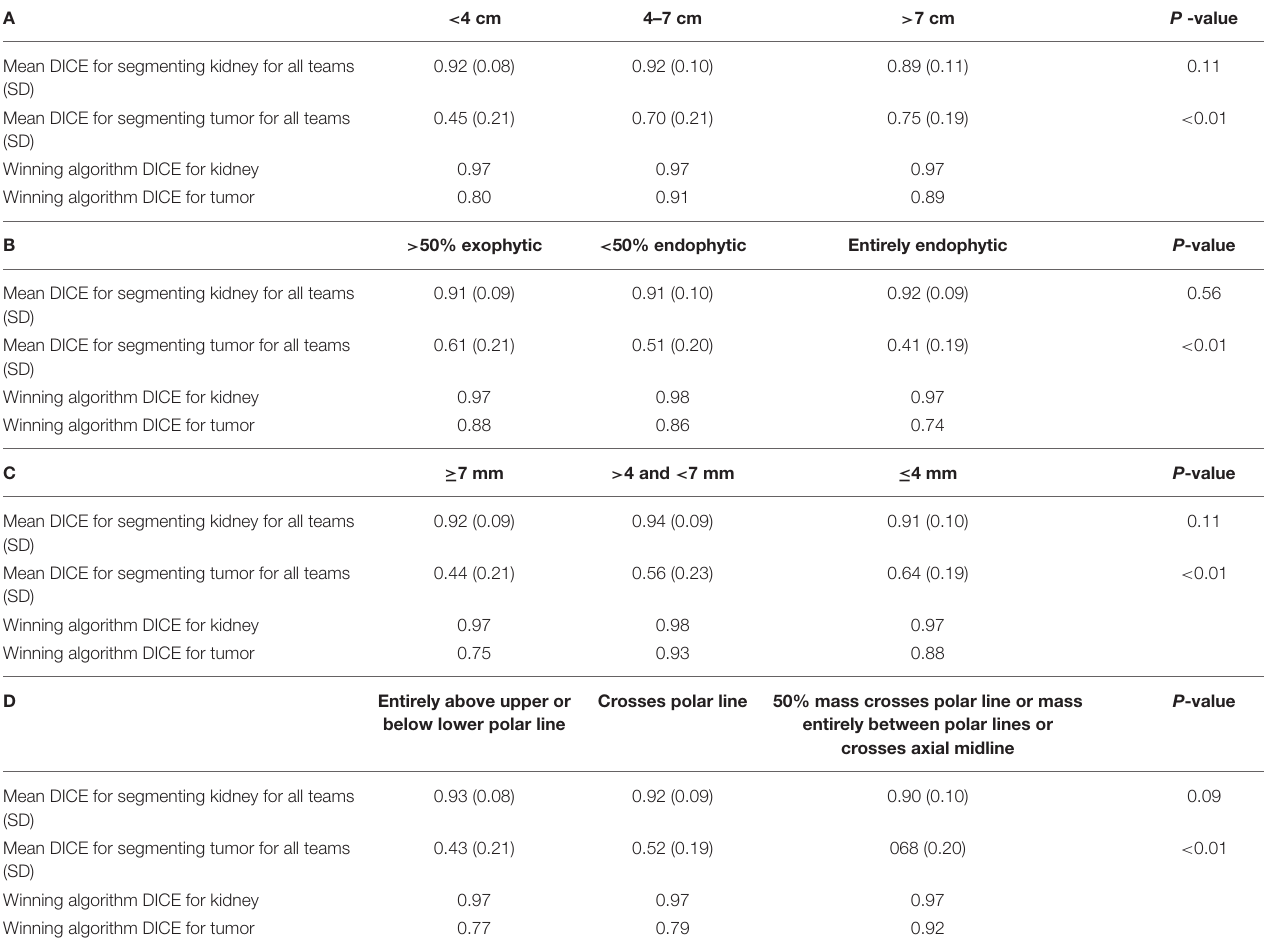
Winning algorithm DICE for kidney